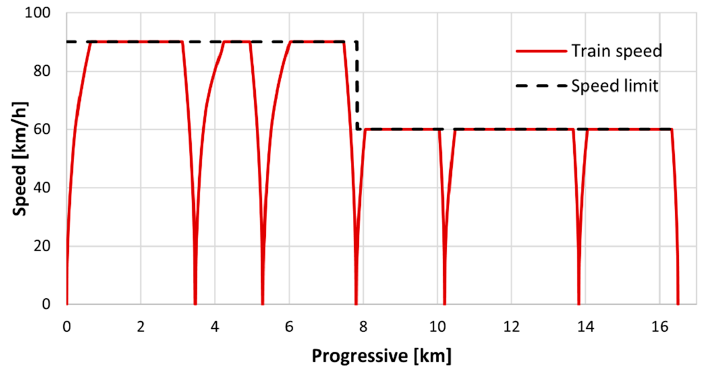
Figure 11. Speed profile from Station A to Station B.